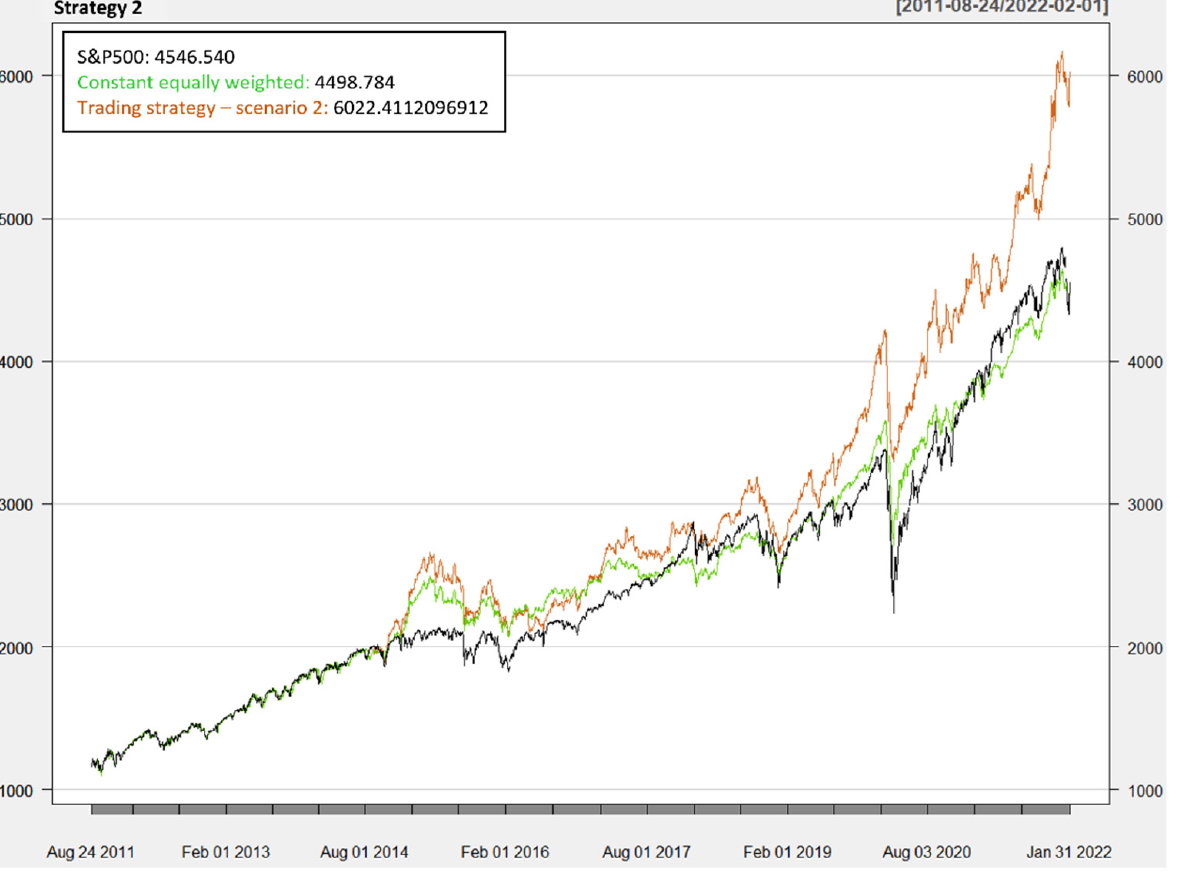
Figure 6 . The asset weights plot of Strategy 2 .